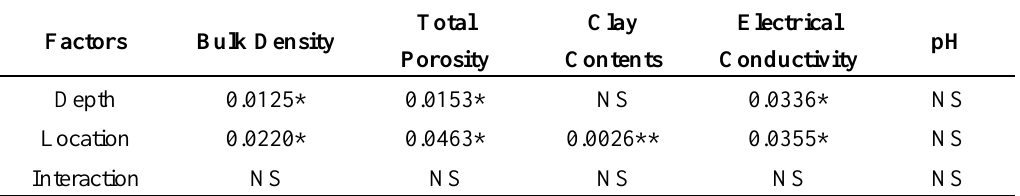
Table 4. Results of the factorial general analysis of variance for bulk density, porosity, and clay contents, electrical conductivity, and pH as a function of soil depths and